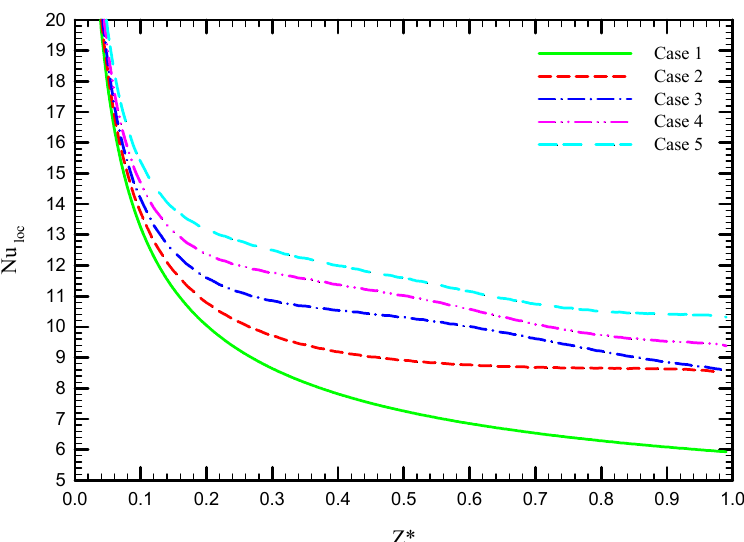
Figure 5. Local Nusselt number along the dimensionless tube length for the captured cases at Re = 250 φ = 0%.